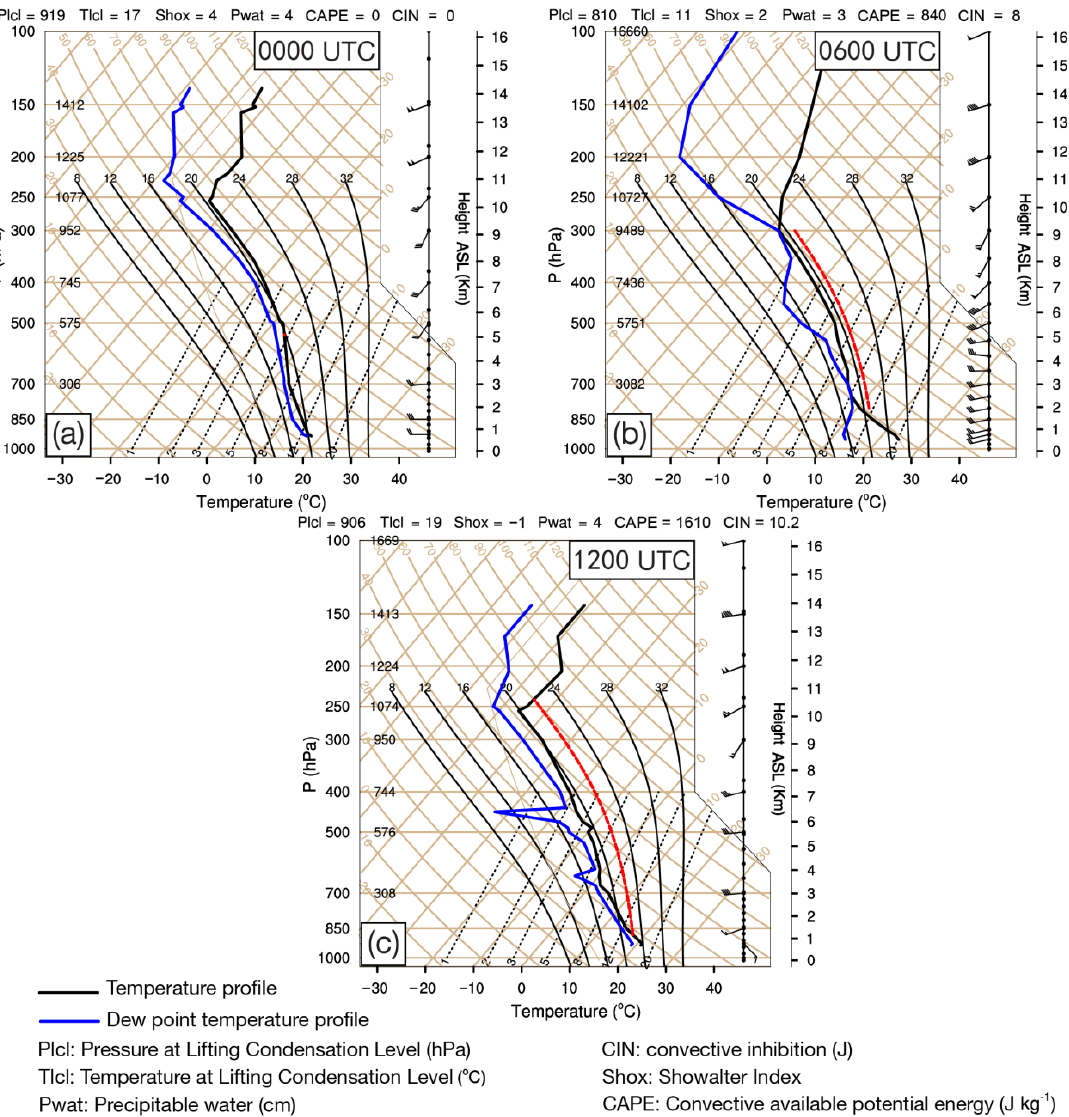
Figure 6. ( a ) Skew T-logP diagram derived from observed balloon sounding at Yining weather station (marked with symbol “×” in Figure 1a) on 17 June 2016. ( b ) is the same as ( a ) but for derived from the NCEP FNL data, which is located at (44° N, 81° E) (marked with symbol “ on 17 June 2016. ( c ) is the same as ( a ) but for the observation at 1200 UTC, the specific time is shown in the upper right corner of each panel.